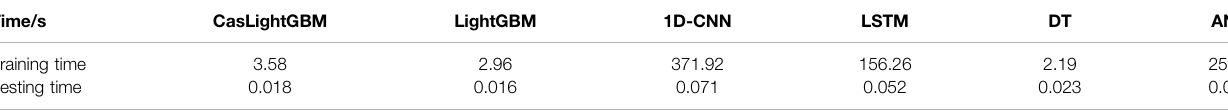
TABLE 4 | Calculation time of different methods.